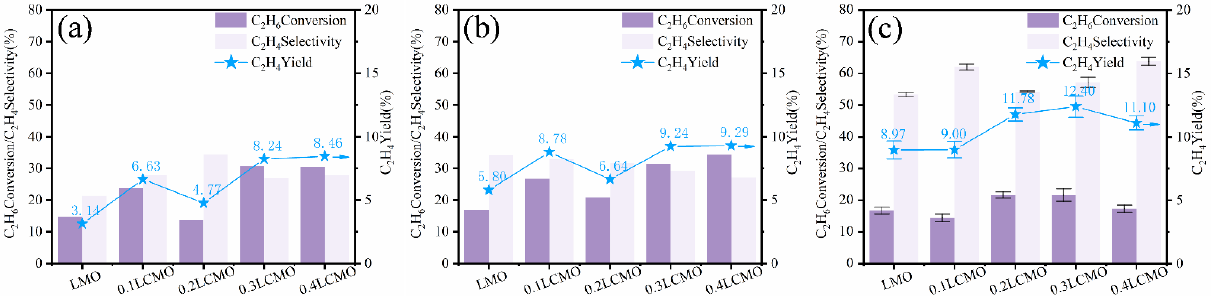
Figure 6. The 0.2LCMO continuous pulse experiment at 700 ° C (GHSV = 1200 mL/h·g).